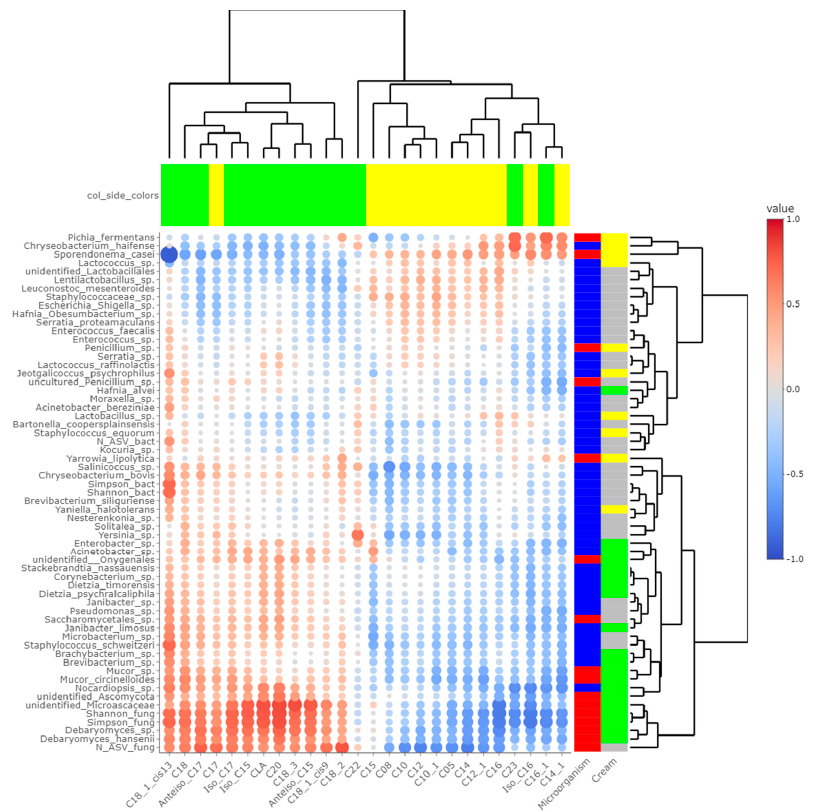
Figure 5. Correlations between metabarcoding data and fatty acids identified by [4] as significantly different between P- and M-derived cheese rinds; blue to red scale indicates the value of correlation coefficient; point size is proportional to –log 10 of p-value; colors in column margin indicate whether the concentration of the concerned FA was significantly higher in P- (green) or M- (yellow) derived cheese rinds; colors in line margin indicate whether the concerned taxon is a bacterium (blue) or fungi (red) and whether taxon was more abundant in P- (green) or M- (yellow) derived cheese rinds or with a similar abundance between both rinds (grey).